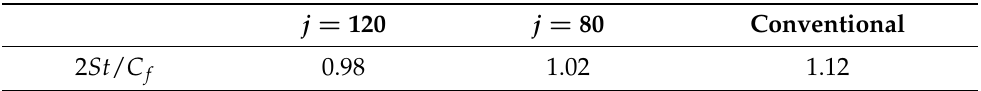
Table 6. Effect of Number of Cells in the Boundary Layer on Reynolds Analogy Factor (2 St / C f ) for Condition No. 2.